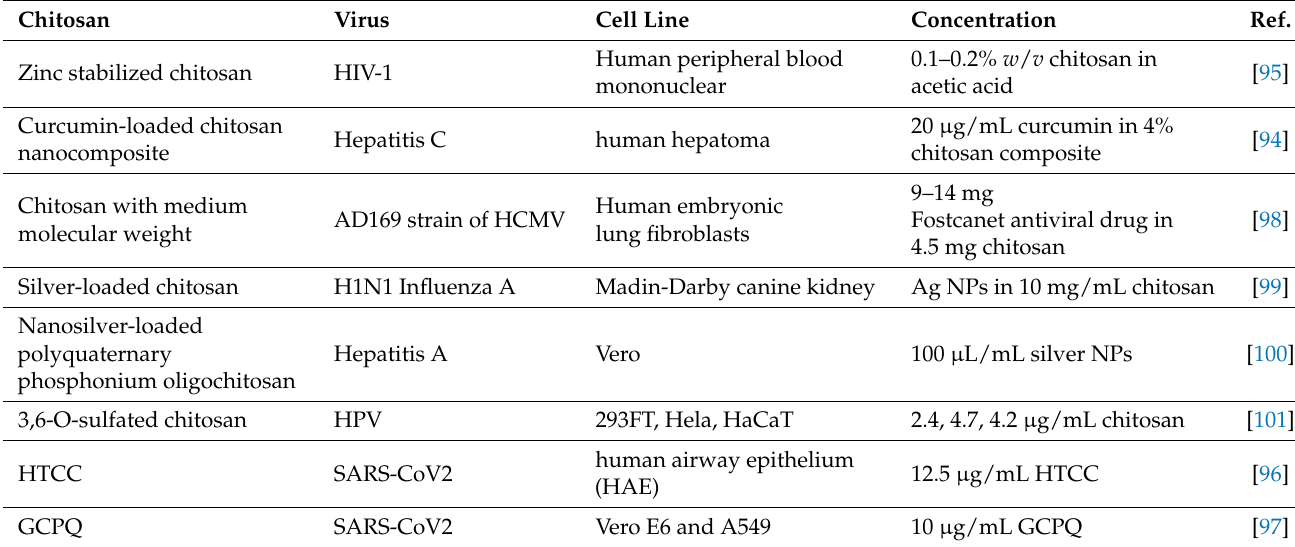
Figure 7. Chemical structures of N -(2-hydroxypropyl)-3-trimethylammonium chitosan (HTCC) and N -palmitoyl- N -monomethyl- N , N -dimethyl- N , N , N -trimethyl-6- O -glycolchitosan (GCPQ) with quaternary ammonium functional groups. Table 3. Antiviral activity of chitosan and its